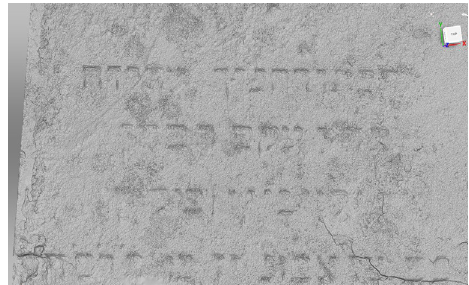
Figure 6. Surface geometry (Artec Spider) after processing.